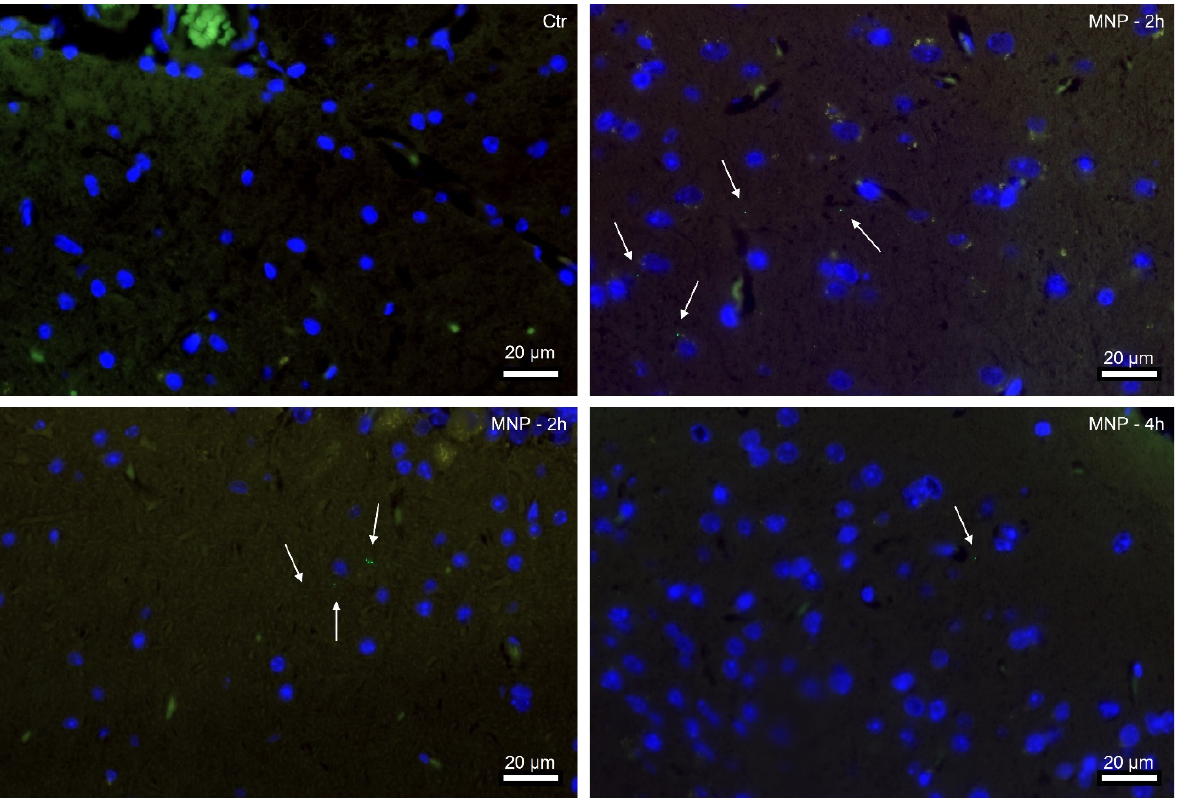
Figure 3. Nanometer-scale PS plastic particles were detected in mouse brain only 2 h after admin- istration. Representative immunofluorescence images of male mouse brains, control (Ctr) and 2 or 4 h after single dose MNP gavage. Tissue sections were counterstained with Dapi (blue). Arrows indicate green fl uorescent nanoplastic particles (0.293 ± 0.008 µm). Scale bar 20 µm.